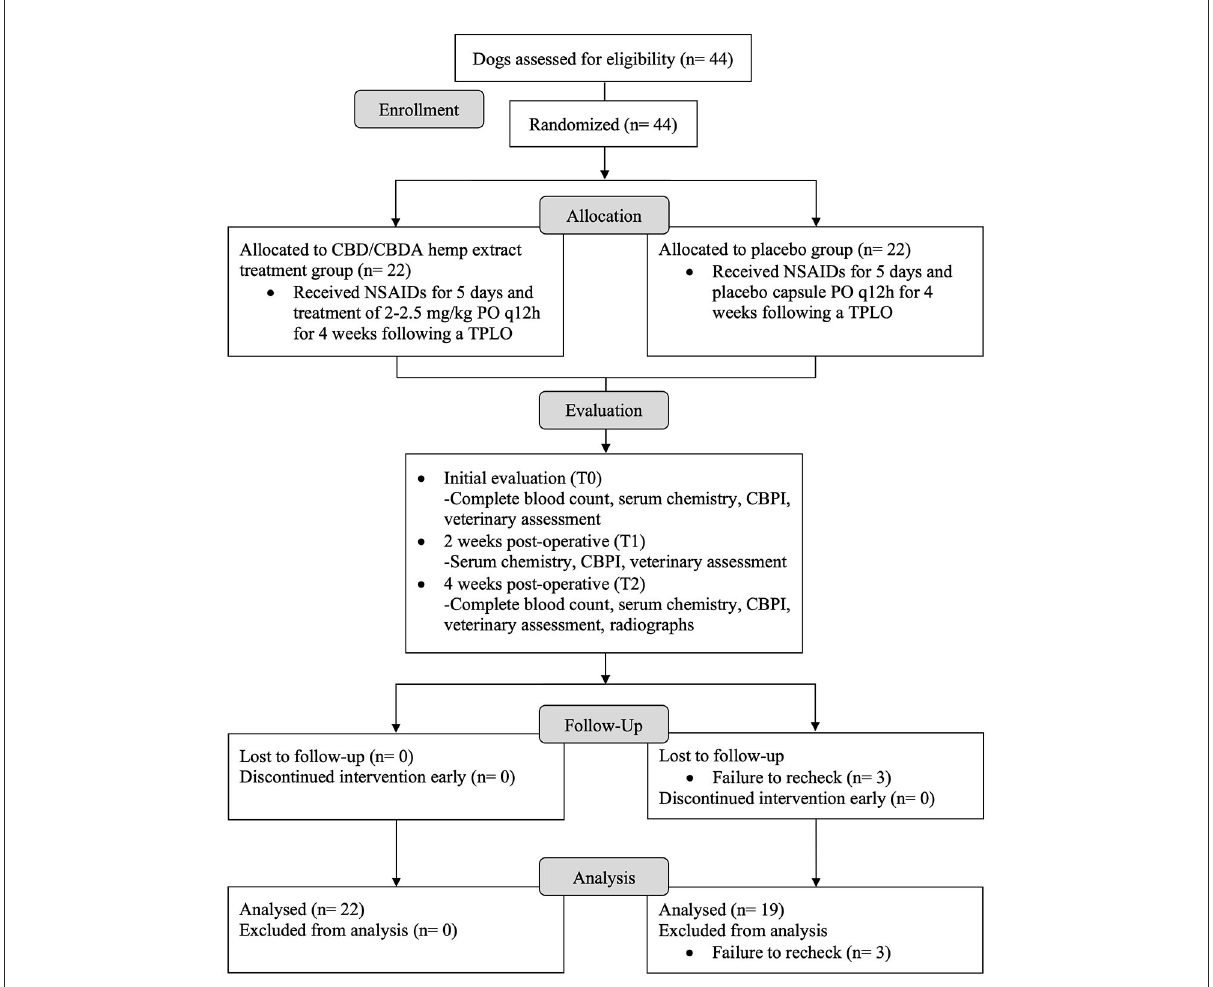
FIGURE1 Flow diagram for a randomized, blinded, placebo-controlled design study to evaluate the effects of a cannabidiol (CBD) and cannabidiolic acid (CBDA) rich hemp product on post-operative pain, complete blood count, serum biochemistry, and early bone healing in dogs following a tibial plateau leveling osteotomy